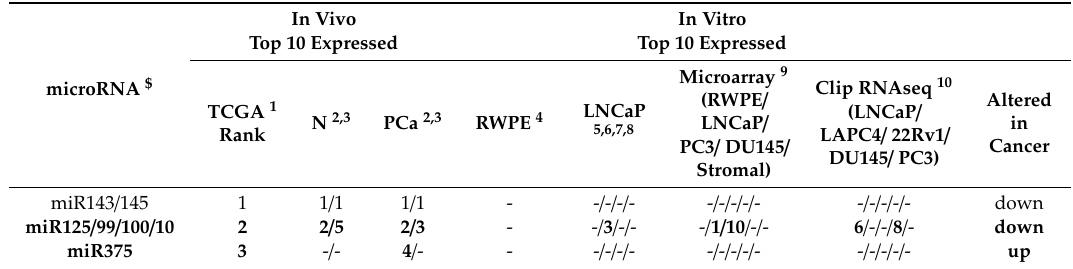
Table 1. Overview of the most highly expressed microRNAs (miRNAs) in normal prostate, prostate cancer (PCa) tissues and prostate cancer cell lines. MiRNAs were ranked from 1 to 10 in each of the datasets that were used to generate this table. If a miRNA was not ranked in the top10 of a dataset, then this is indicated by a “-”. $ : miRNA family or cluster (bold highly conserved, ancient common to proto- and deuterostoma). Striking di ff erences for example between 5–8 experiments all on LNCaP: miR-378, miR-30, miR-21 are some of the highest in 8 but are far less expressed in the other three experiments indicating di ff erences in culture methods or di ff erences due to LNCaP subclones that may have evolved during prolonged cultivation. It remains to be seen whether the miRNAs that are di ff erentially expressed between the LNCaP “clones” are relevant or not. A “-” means that in this particular experiment, the miRNA was not in the top 10 expressed group of miRNAs. For example, in the last “in vitro” column for “Clip RNAseq” for five prostate cancer (PCa) cell lines, “6 / - / - / 8 / -” in the miR-125 column means that members of the miR-125 were expressed in the top 10 in LNCaP and DU145. In the other three cell lines, at least 10 other miRNAs were more highly expressed than miR-125 family members. Each experiment included in the table is represented either by a number or rank or a “-” indicating the expression level / rank in each experiment with “-” indicating that the miRNA was not ranked in the top 10. N: normal, PCa: prostate cancer. 1 : examples from the TCGA miRNA RNAseq data collection on prostate cancer (https: // cancergenome.nih.gov). 2 : [48]. 3 : [49]. 4 : GSE71081. 5 : [50]. 6 : [51] 7 : GSE71336. 8 : GSE66035. 9 : GSE40026. 10 :